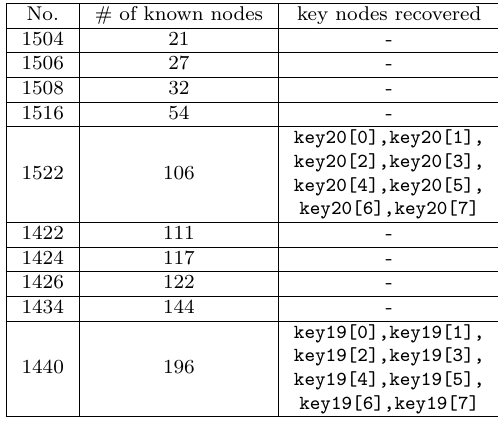
Table 11: Attack on PRIDE found by TADA - Each row corresponds to a vulnerable instruction with sequence number “No.” such that after the attack on this instruction, the number of known nodes is given by “# of known nodes” and the key nodes that are retrieved are given by the third column.